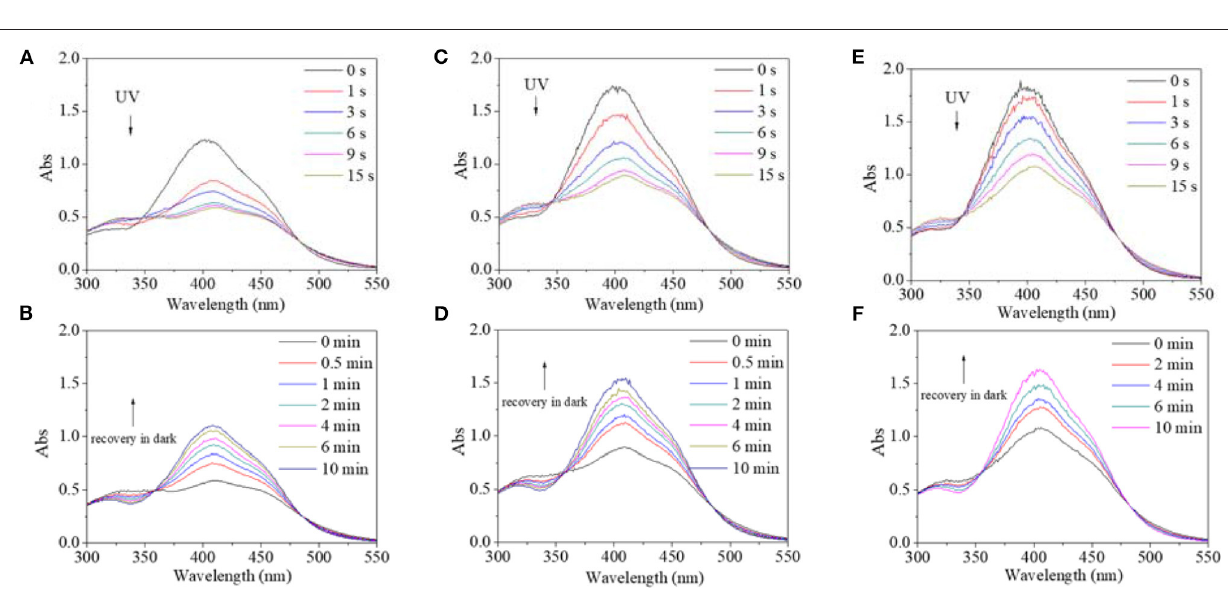
FIGURE 8 | UV spectra of PBLG2 solution with 20% alcohol (A,B) , 40% alcohol (C,D) and 60% alcohol (E,F) as a function of irradiation time (a, c) and recovery time (B,D) . Irradiation was performed under UV light, and recovery process was performed under darkness and room temperature. Polymer concentration was 0.65 mg/mL for (A,B) , 0.88 mg/mL for (C,D) , 0.94 mg/mL for (E,F)